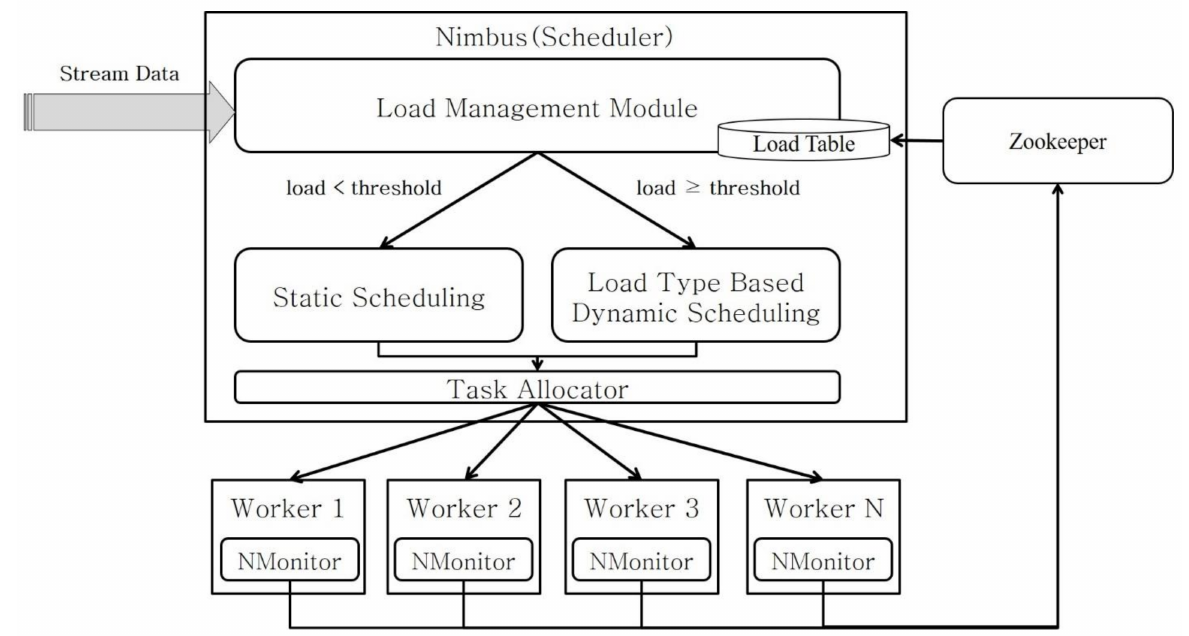
Figure 2. Scheduling process.